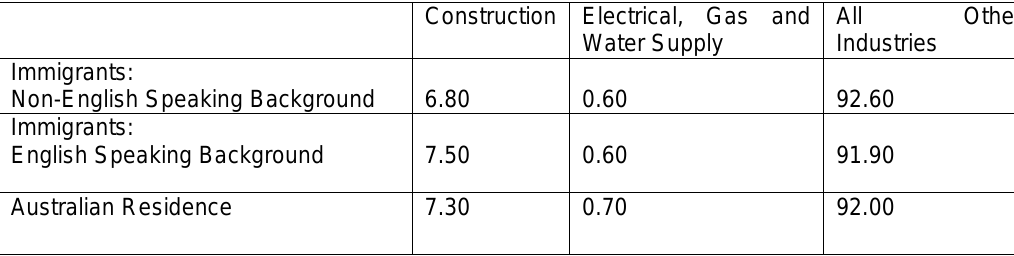
Table 4 Percentages of Immigrants and Australian Residents in the